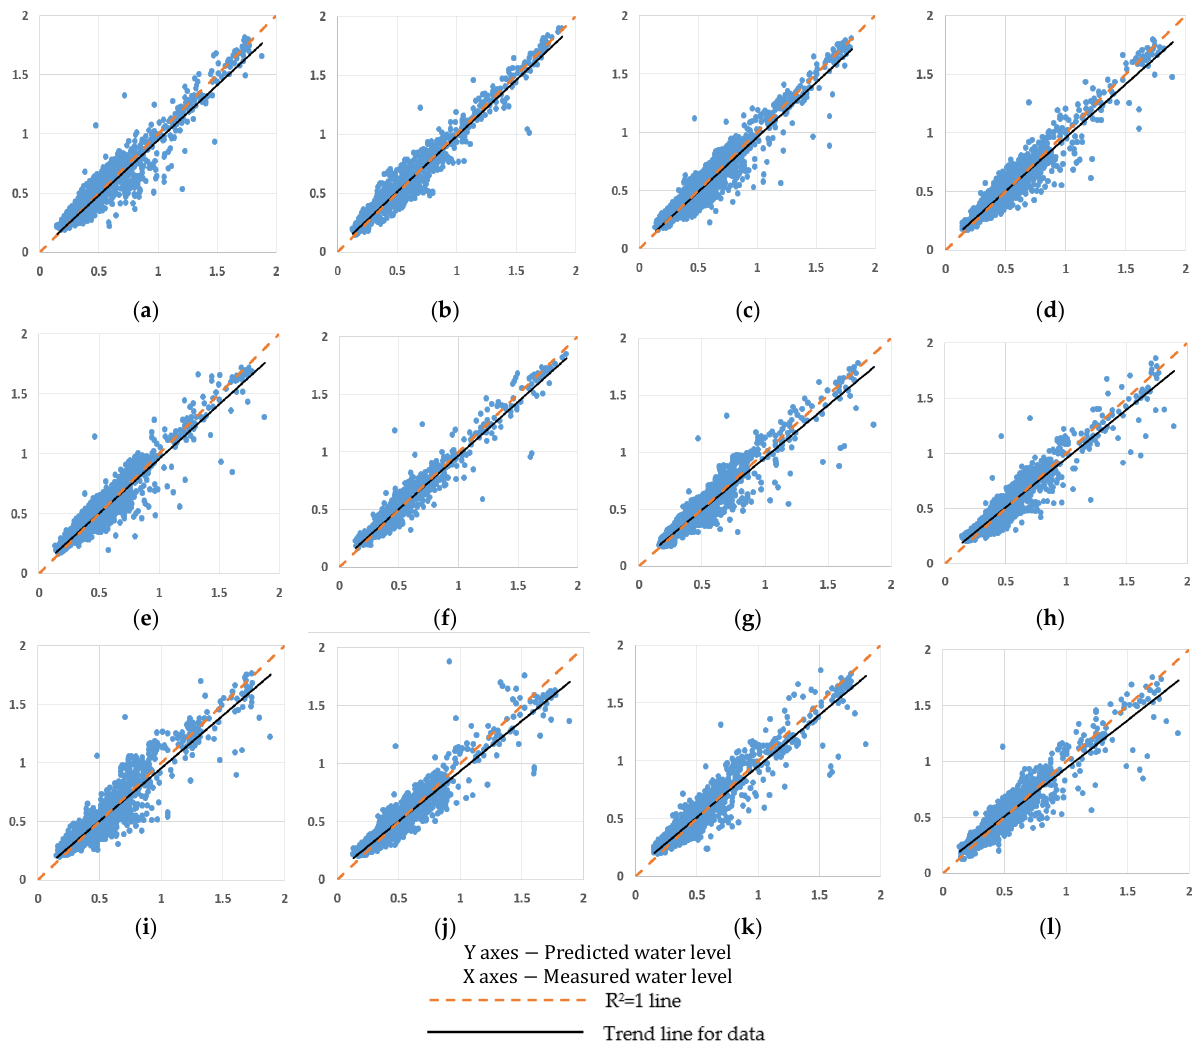
Figure 4. R 2 Plots of Kimbulawala Wetland Water Level Prediction: ( a ) under Evaporation for BR; ( b ) under Rainfall for BR; ( c ) under Relative humidity at daytime for BR; ( d ) under Relative humidity at nighttime for BR; ( e ) under Evaporation for LM; ( f ) under Rainfall for LM; ( g ) under Relative humidity at daytime for LM; ( h ) under Relative humidity at nighttime for LM; ( i ) under Evaporation for SCG; ( j ) under Rainfall for SCG; ( k ) under Relative humidity at daytime for SCG; ( l ) under Relative humidity at nighttime for SCG.